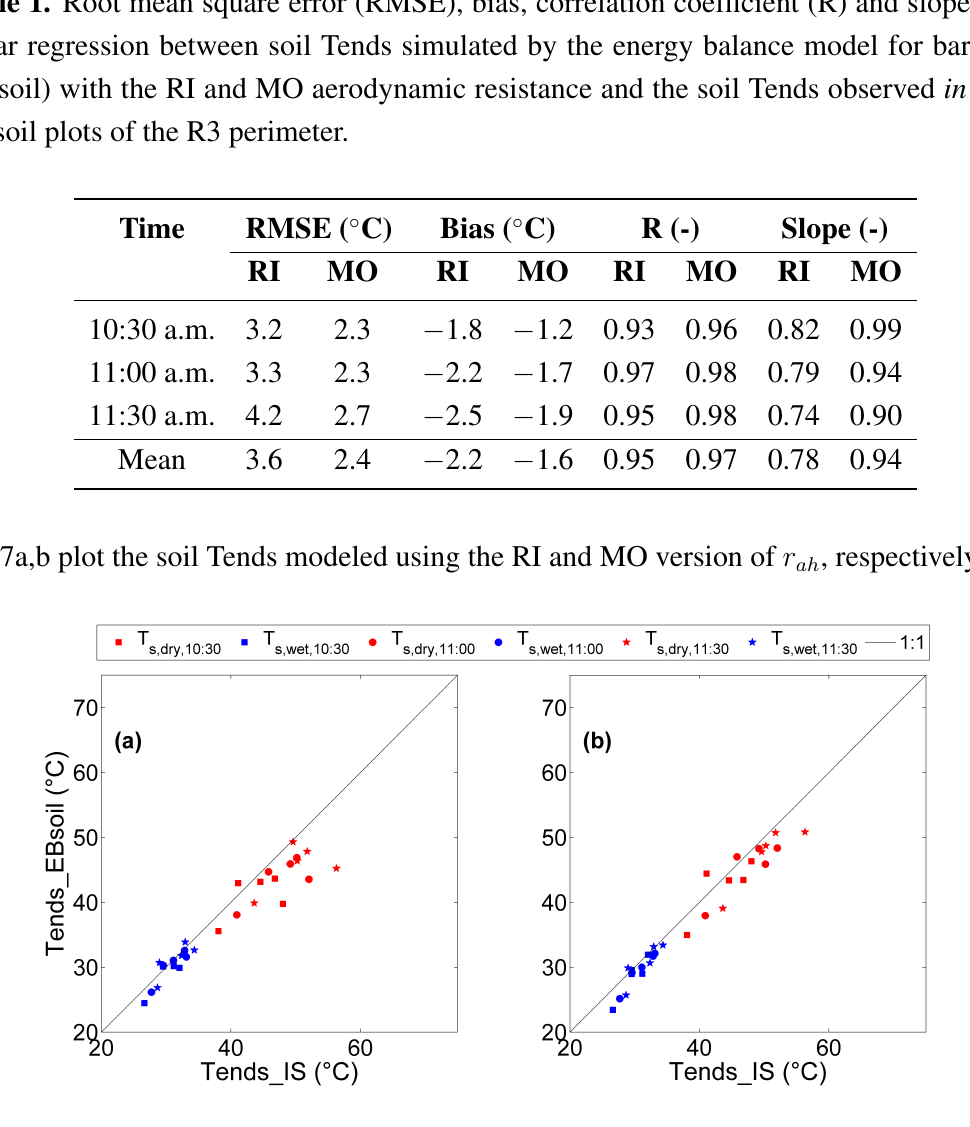
Figure 7. The soil Tends simulated by EBsoil for the ( a ) RI and ( b ) MO aerodynamic resistance are plotted against the soil Tends observed in situ at the two soil plots in the R3